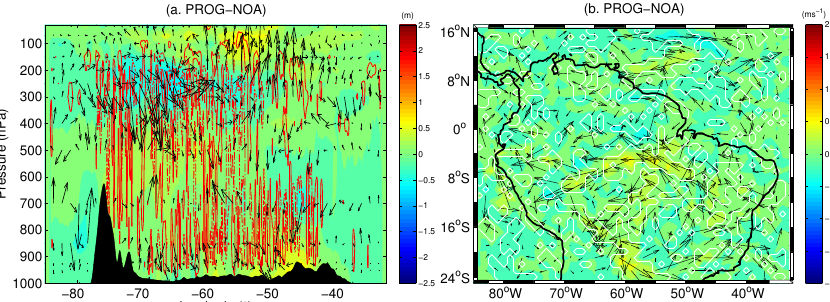
Figure 8. (a) Differences in geopotential height (coloured) and u , v winds (arrows) averaged over 10–13 ◦ S for the SAMBBA whole period for PROG-NOA; red contours show differences in vertical wind (dashed lines show negative values and solid lines positive values). Black masked area is the topography. (b) Circulation and wind speed changes at 700hPa for PROG-NOA. White contour shows where BBA impacts are greater than the standard